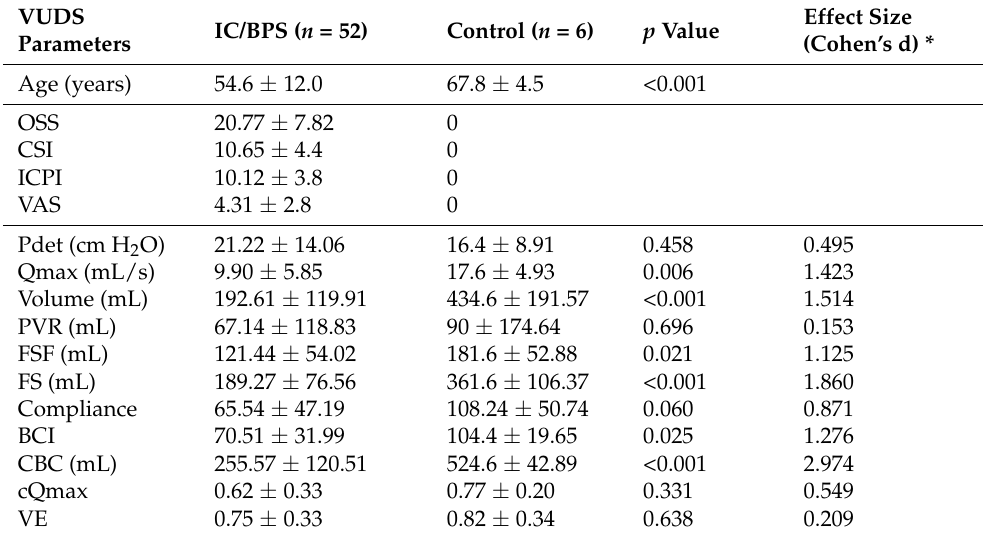
Table 1. The interstitial cystitis symptom score and video urodynamic parameters in interstitial cystitis/bladder pain syndrome patients and controls.